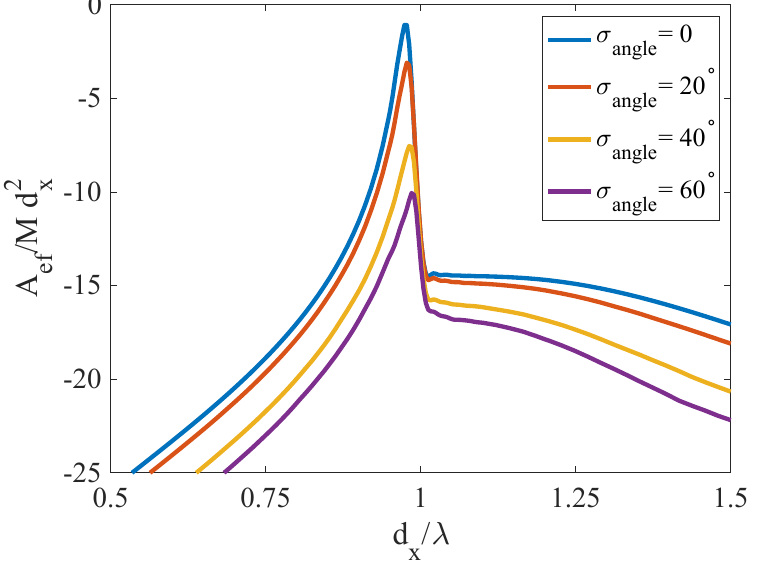
Figure 4. Normalized effective transmitting area of a finite chain of M slots with dimensions l s = 0.4 d x , w s = 0.05 d x with different rotation angles given by a random normal distribution of different standard deviations under normal